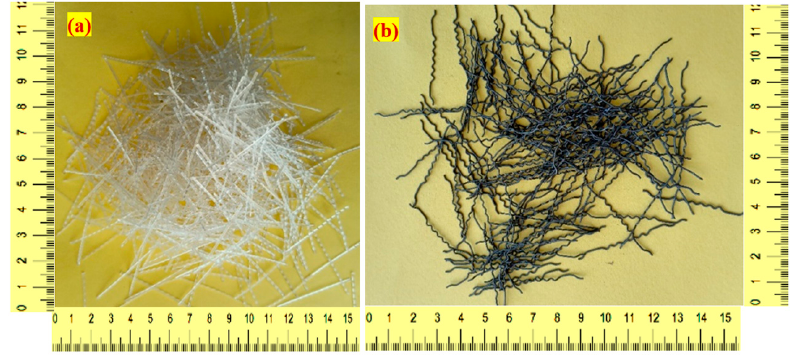
Table 1. Two asphalt thicknesses of 50 and 100 µm were used in the single and double coat- ings, respectively. Figure 4 depicts the surface of coarse aggregate precoated with asphalt.